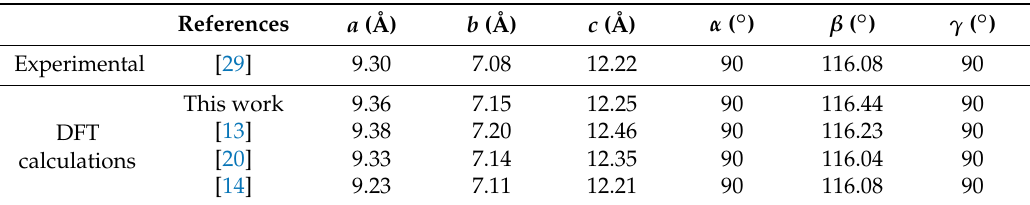
Table 1. Comparison of lattice parameters of M3-C 3 S by experimental measurements and density functional theory (DFT) calculations.